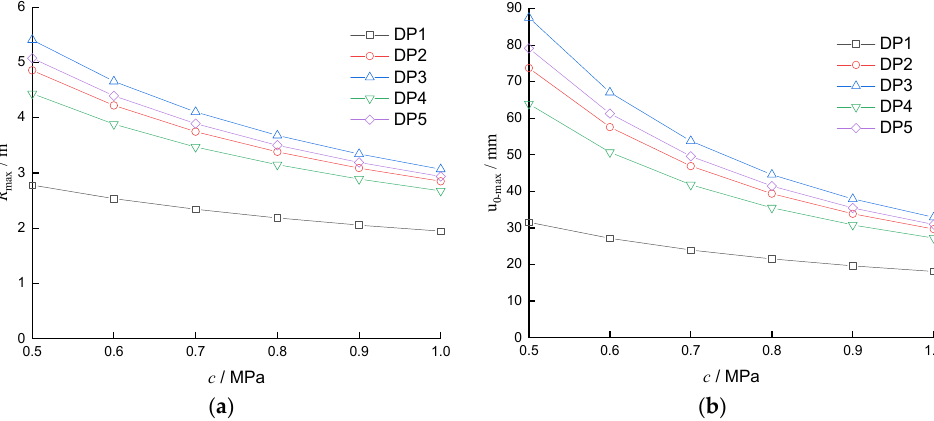
Figure 4. Effect of cohesion on radius and maximum displacement of plastic zone: ( a ) plastic zone radius; ( b ) allowable maximum displacement.